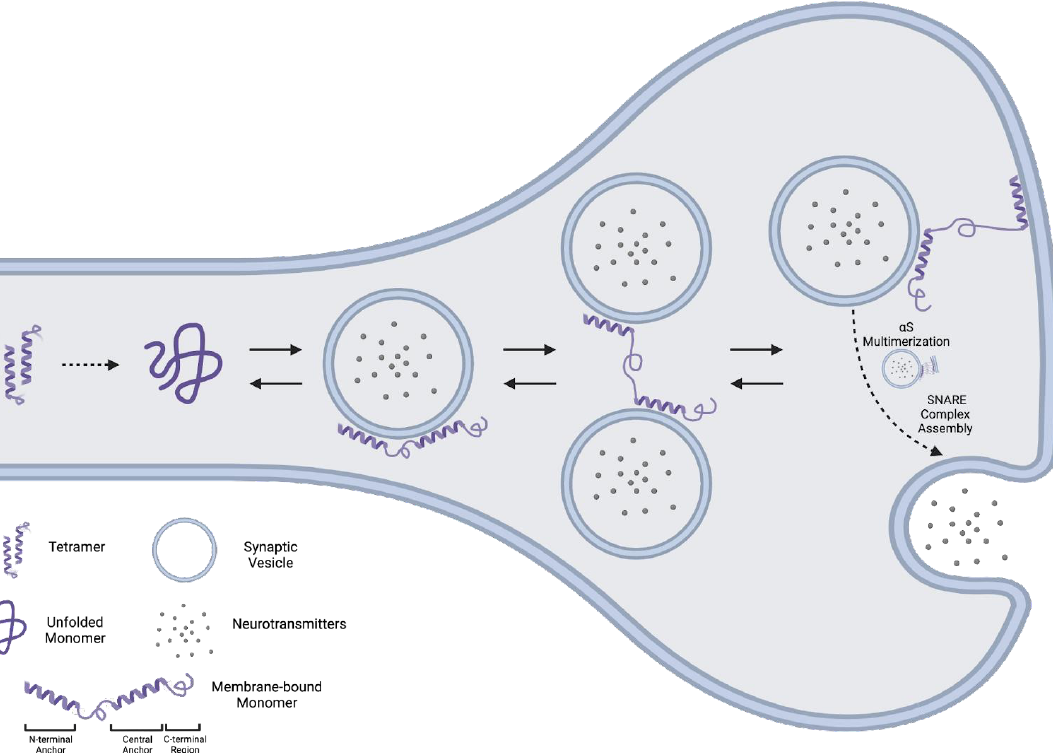
Figure 1. Physiologic conformations of α S. Steady-state populations of cytosolic and membrane- associated α S exist in the cell. Cytosolic α S exists as an unfolded monomer, or, controversially, a folded tetramer (far left), while membrane-bound α S adopts a compact folded structure. Membrane association is stabilized by two α -helical anchors on the N-terminal and central regions of the protein. α S’ anchors may be associated with either the same vesicle (middle left), two different vesicles, promoting vesicle clustering (middle right), or a vesicle and the plasma membrane, tethering vesicles to membrane sites (far right, top). At the presynaptic membrane, α S promotes SNARE complex assembly, the catalytic machinery for synaptic vesicle fusion and neurotransmitter release (far right, bottom). The self-assembly of α S into higher-order “multimers” may be required for this latter